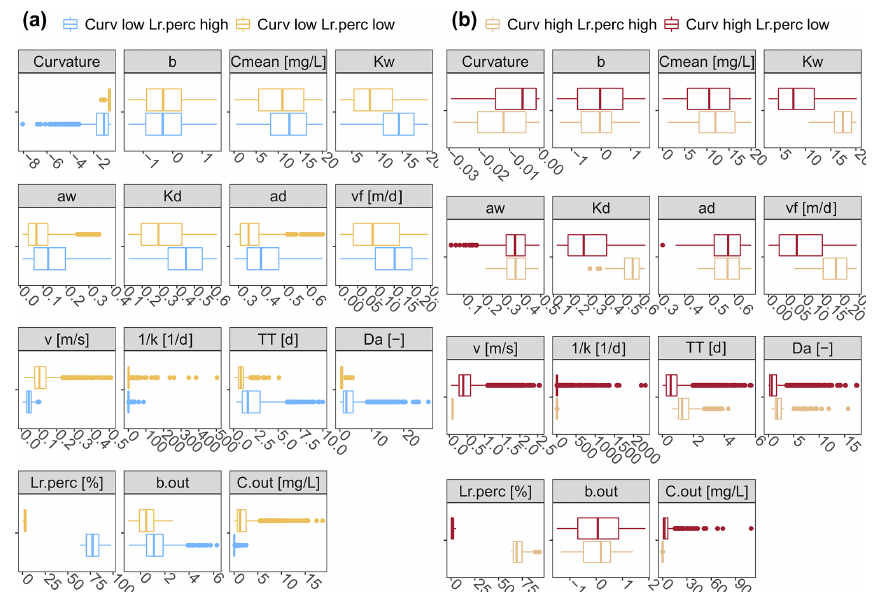
Figure B7. Two specific cases of Fig. 6: (a) when Curv max is low (high bending) and L r.perc is low as opposed to high and (b) when Curv max is high (low bending) and L r.perc is high as opposed to low.